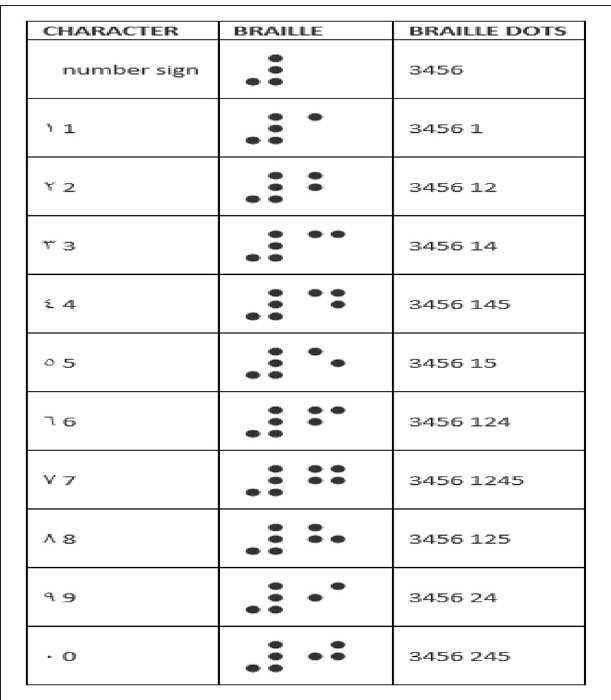
FIGURE 10 | Arabic Digit to